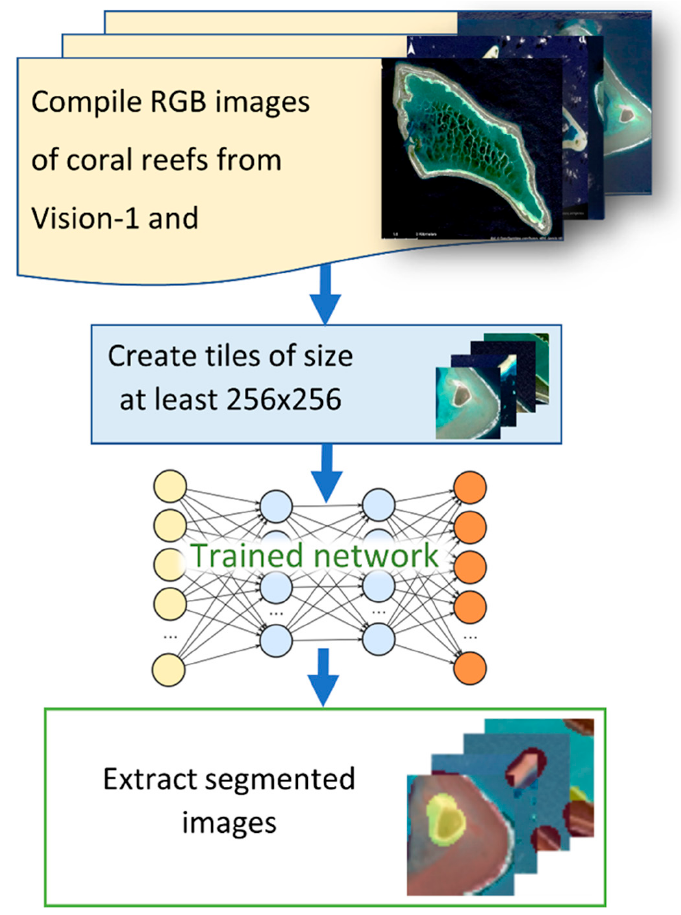
Figure 6. Flowchart showing the procedure of using the trained deep learning network to segment